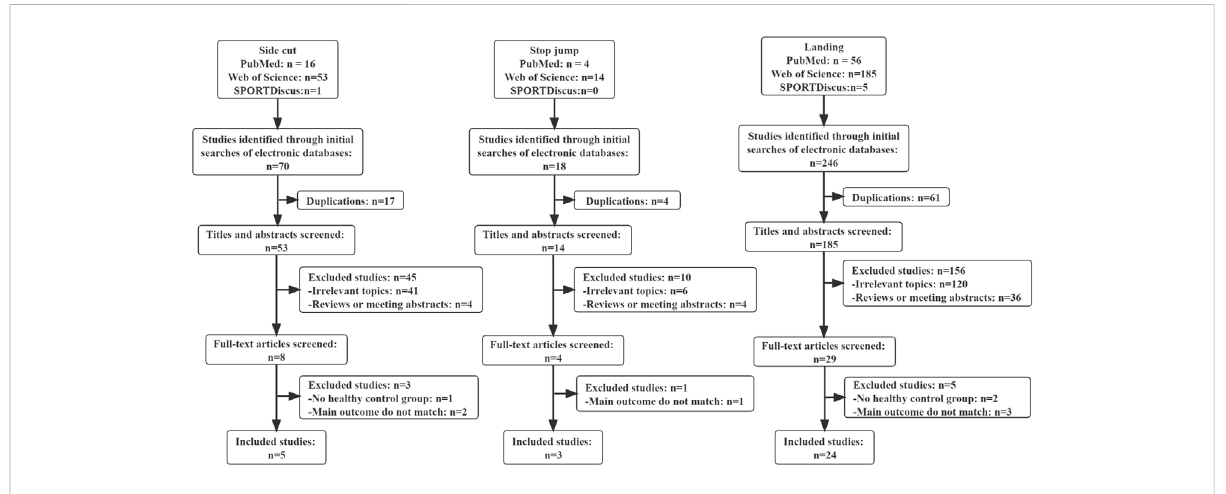
FIGURE 1 Flow chart of literature search and